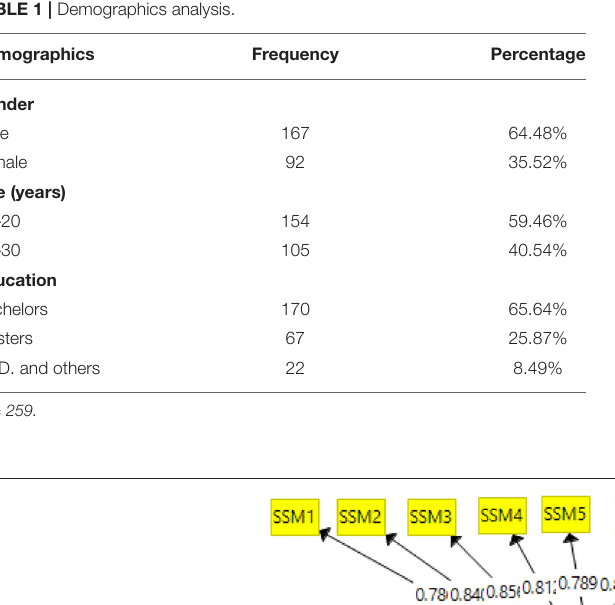
Frontiers in Psychology |